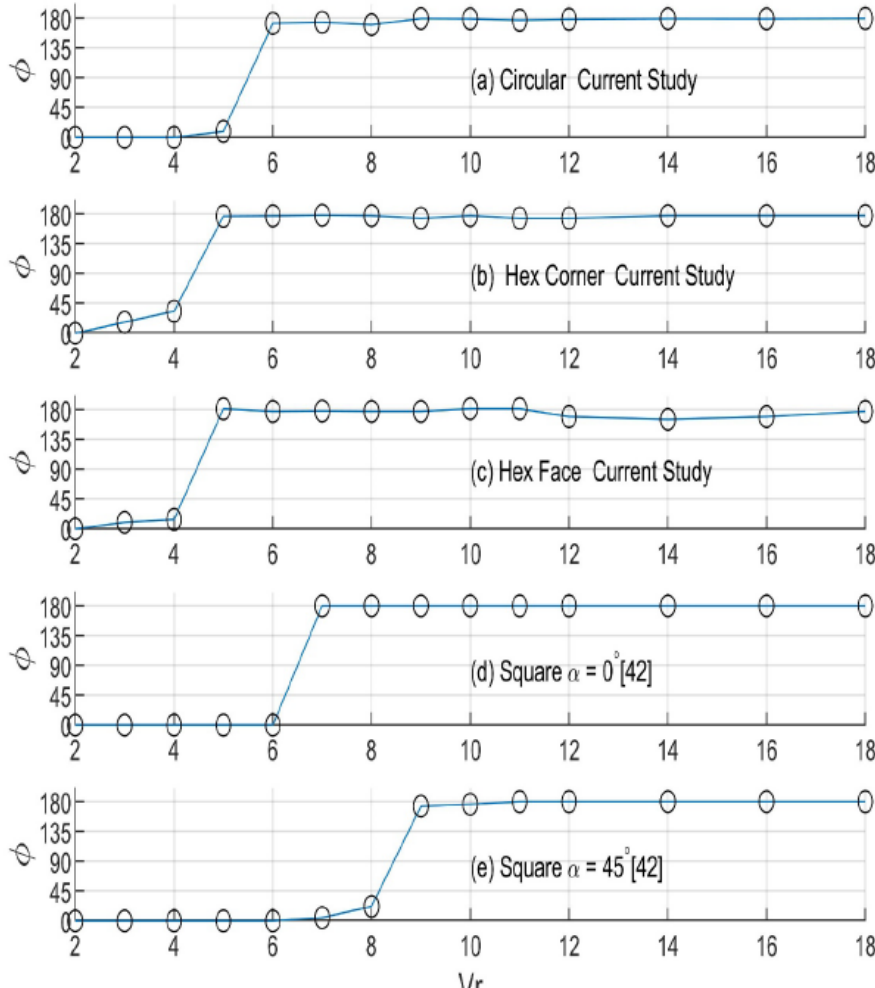
Figure 5. Time histories of the (a) lift coefficient and (b) normalized amplitudes of the face-oriented hexagonal at 𝑉𝑟 = 2, 𝑉𝑟 = 5, 𝑉𝑟 = 10, and 𝑉𝑟 = 18.